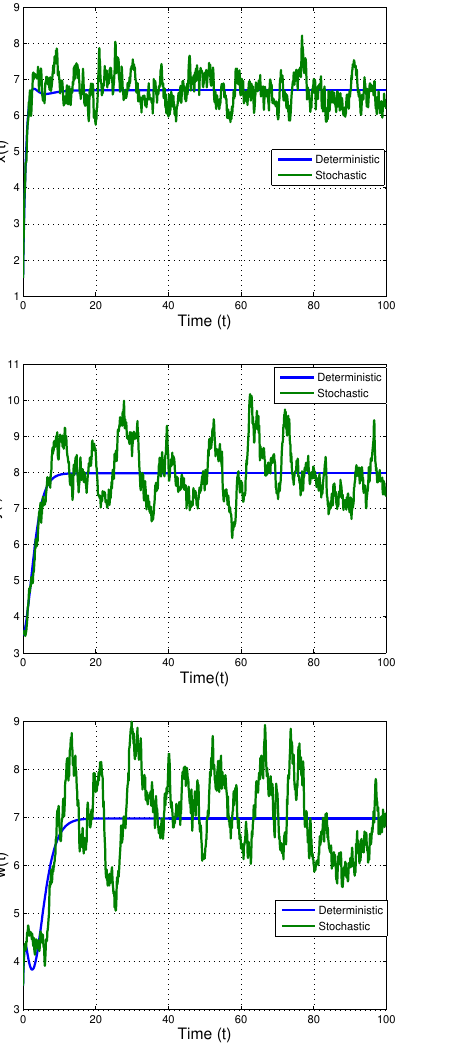
Figure 1. Shows time trajectories of ( x ( t ) , l ( t ) , y ( t ) , v ( t ) , w ( t )) of the stochastic model (2) with = 1.5886 > 1 and its corresponding deterministic σ 1 = 0.9, σ 2 = 0.9, σ 3 = 0.7, σ 4 = 0.9, σ 5 = 0.8 ( R s 0 model. The solution fluctuate randomly with respective stochastic mean,